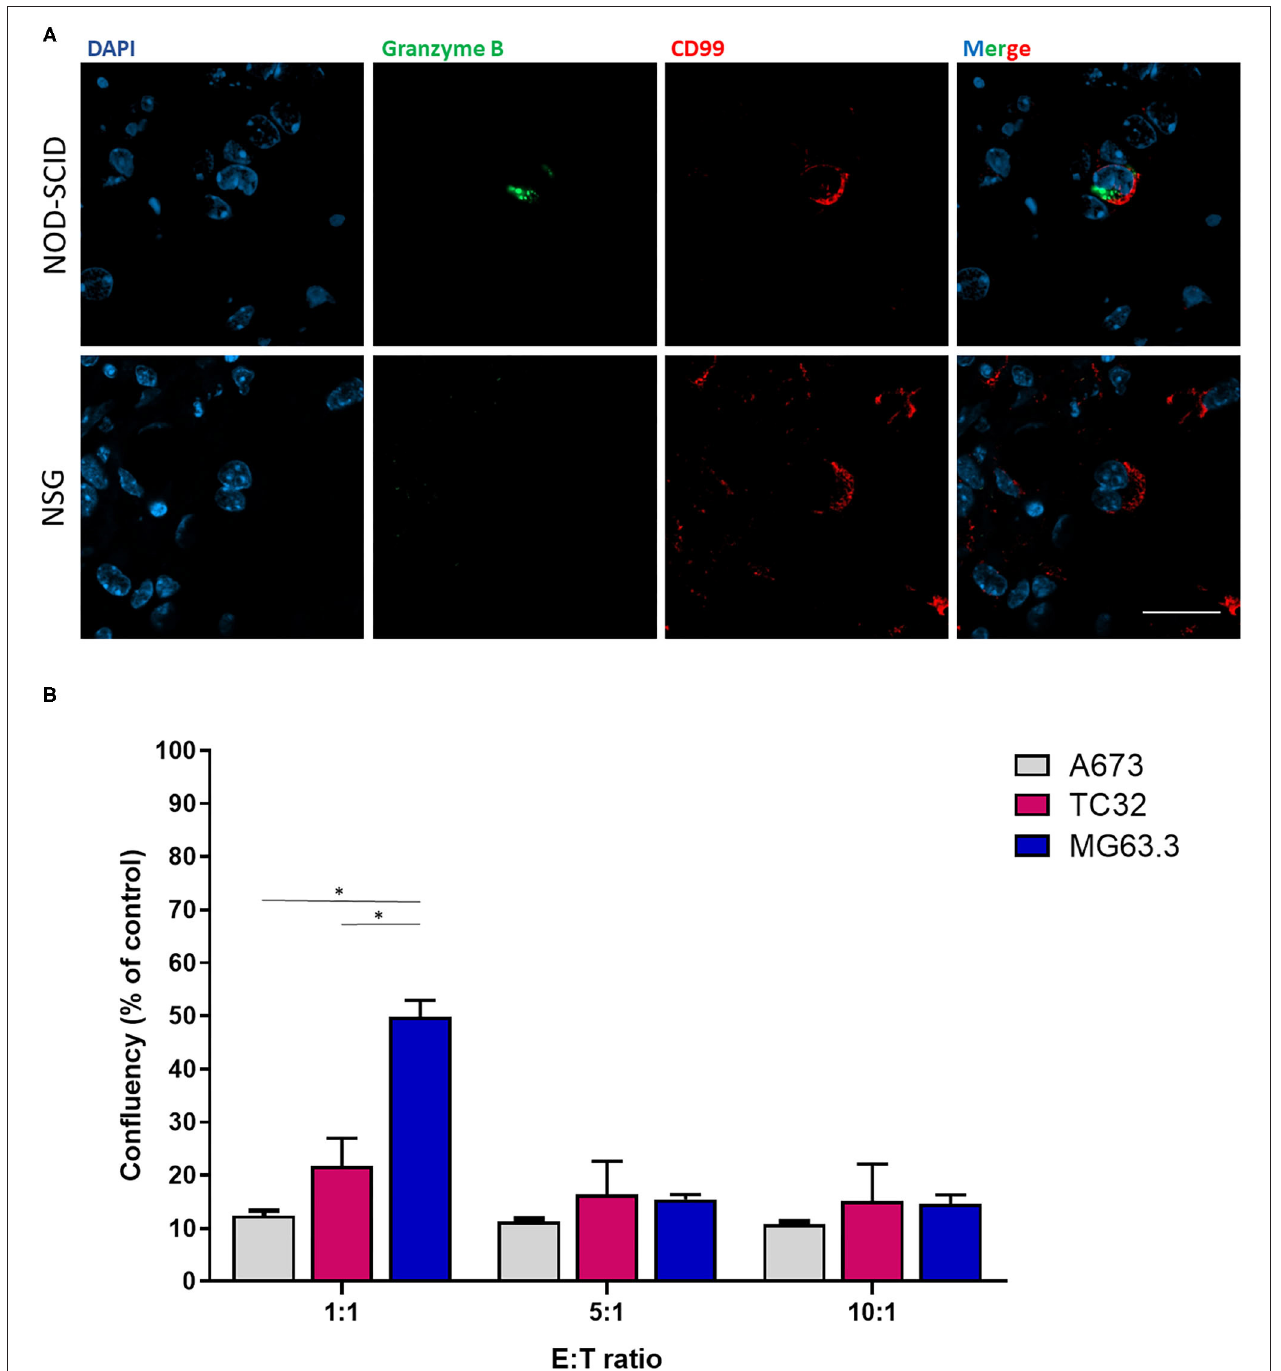
FIGURE 3 | Effects of NK cells on ex vivo and in vitro EwS cell growth. (A) Granzyme B and CD99 co-staining in NOD-SCID and NSG mice at 3-days post-injection of EwS cells. Three animals were included per group ( n = 3) and a minimum of 10 lung tissue sections were analyzed per animal. (B) NK92 cytotoxic effects on EwS compared to OS cells. Ratio-dependent cytotoxicity of NK92 cells was determined for A673, TC32, and MG63.3 cells. Bar graphs represent the mean ± SD of a minimum of three independent experiments. Statistical analysis of differences was calculated using a Student’s t -test (* p <